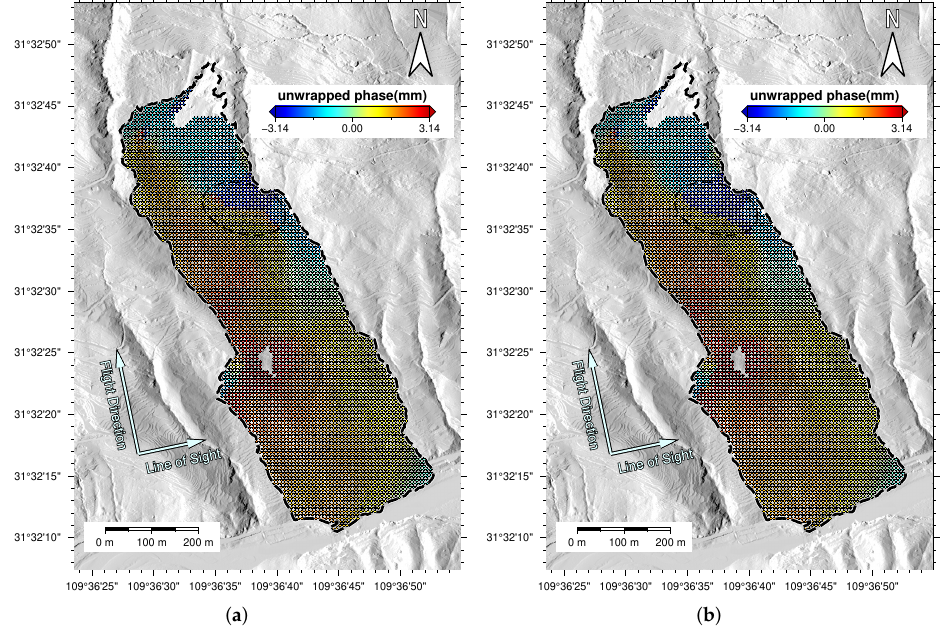
Figure 3. Unwrapped phase in map coordinates ( a ) without and ( b ) with the correction using the proposed method. The area with the obvious phase unwrapping error observed is highlighted by the black